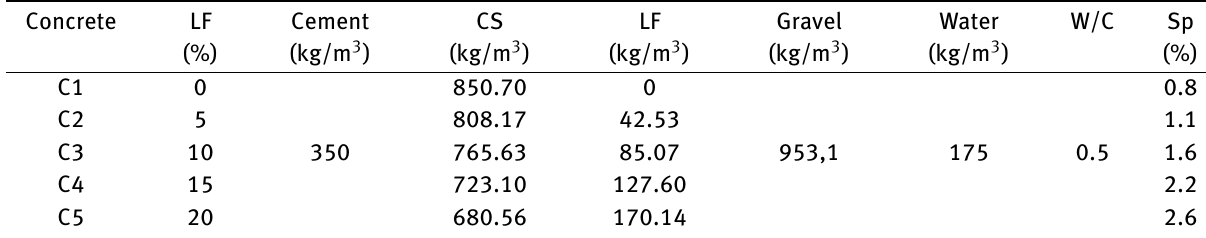
Table 2: Concrete composition for 1 m 3 .